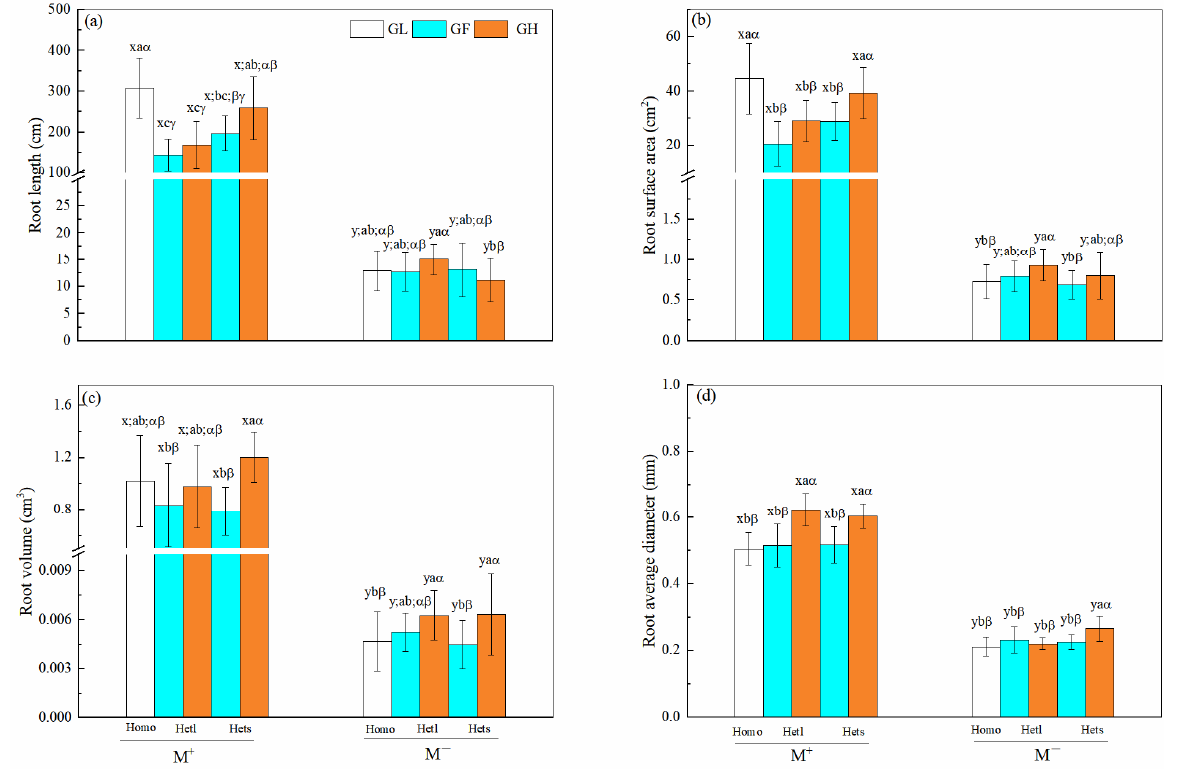
Figure 3. Phenotypic traits of B. pilosa roots. ( a – d ) represent the root length, surface area, volume and average diameter, respectively. See Figure 2 for an explanation of M + , M − , Homo, Hetl, Hets, GL, GF, and GH, lowercase letters (x, y) and (a, b, c) and Greek alphabet ( α , β , γ ).